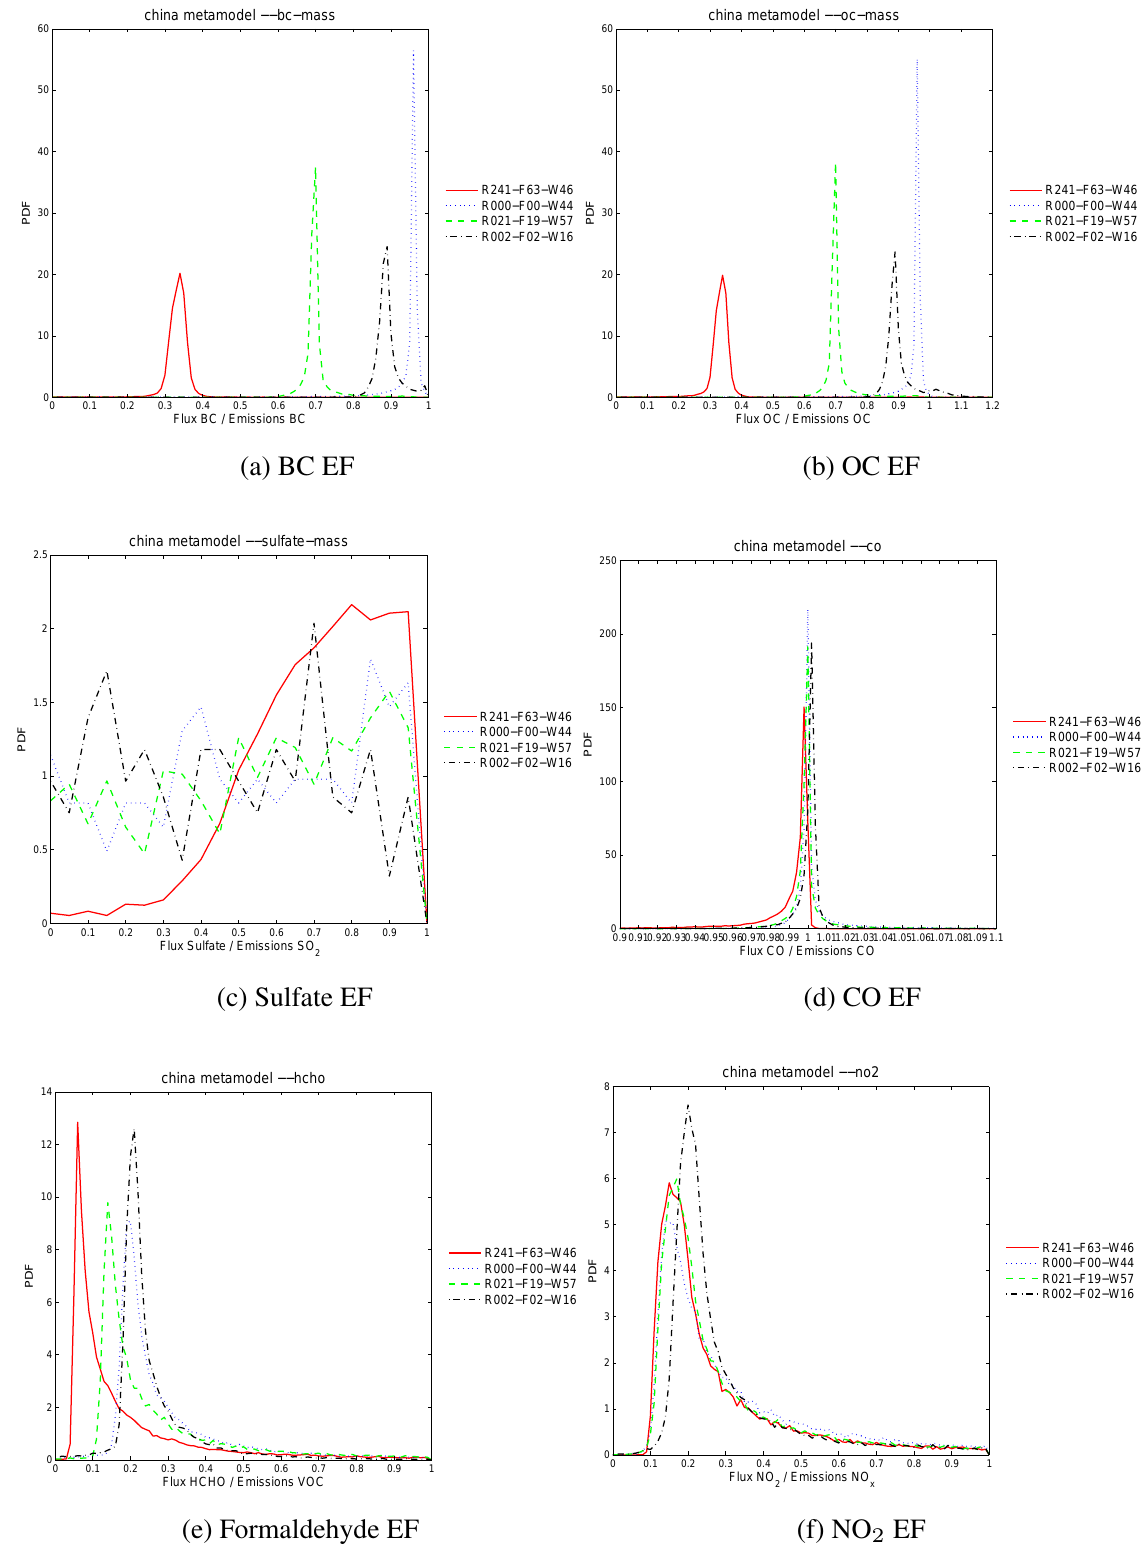
Fig. 8. These are the PDFs of the total urban area EFs (Eq. 8), from the China metamodel. For inputs, please refer to Fig. 5. Fig. 8: These are the PDFs of the total urban area EFs 8, from the China metamodel. For inputs, please refer to Figure 5 Atmos. Chem. Phys., 11, 7629–7656,